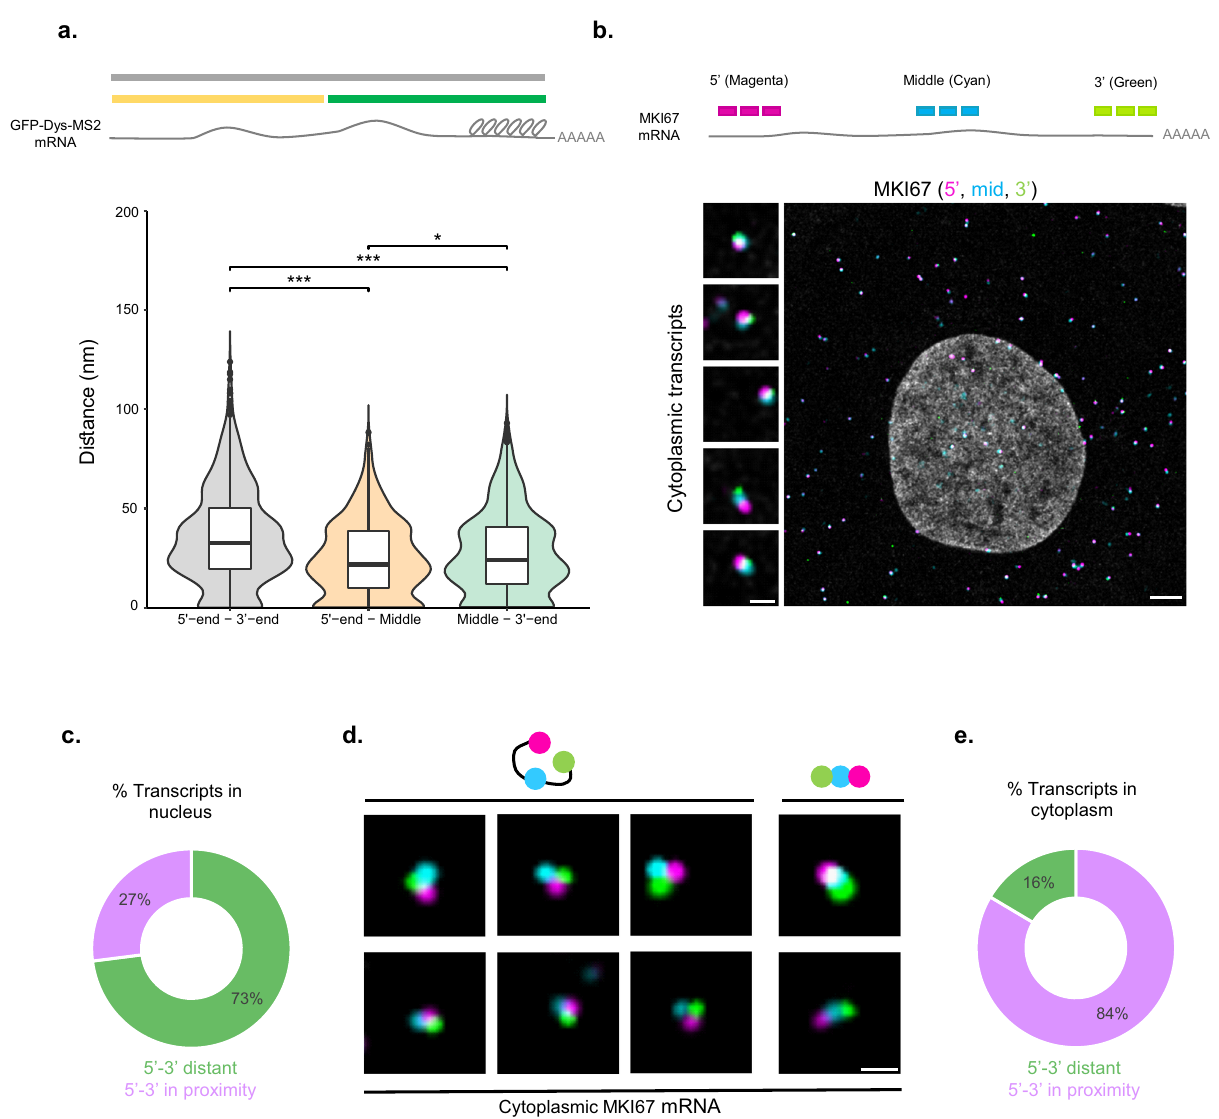
Fig.3| NucleoplasmicmRNAsaremostlyrod-shaped.a SchemeoftheGFP-Dys- MS2mRNAandthedistancesmeasured.Violinplotdepictingstart-to-end,start-to- middle and middle-to-end distances at three different nuclear regions. 5 ’– 3 ’ n =1040; 5 ’ -mid n =746; mid-3 ’ n =917 transcripts. (Kruskal – Wallis, χ 2 (2)=12.825, p <0.0001. Pairwise comparisons — two-sided Mann – Whitney tests with Benjamini – Hochberg FDR correction, 5'-end – 3'-end vs. 5'-end-Middle p <0.0001, 5'-end – 3-end vs. Middle-3'-end p <0.0001, 5'-end-Middle vs. Middle-3'e-nd p =0.013). * p <0.05, *** p <0.001. Boxplots show the distance (nm) (center line, median; box limits, upper and lower quartiles; whiskers, 1.5× interquartile range; dots, outliers). b Scheme showing the sites ofrecognition betweenprobe sets and